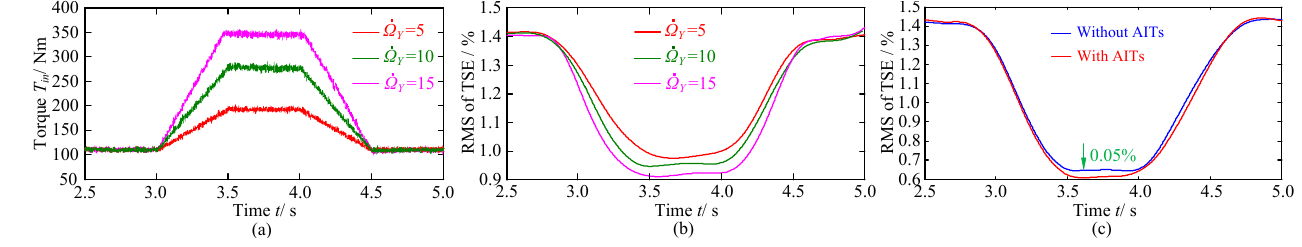
Figure 22. Torque and RMS value of TSE: ( a ) torque of PMSMs under different rotating accelera- tions; ( b ) RMS values of TSE under different rotating accelerations; ( c ) RMS values of TSE with or without AITs.